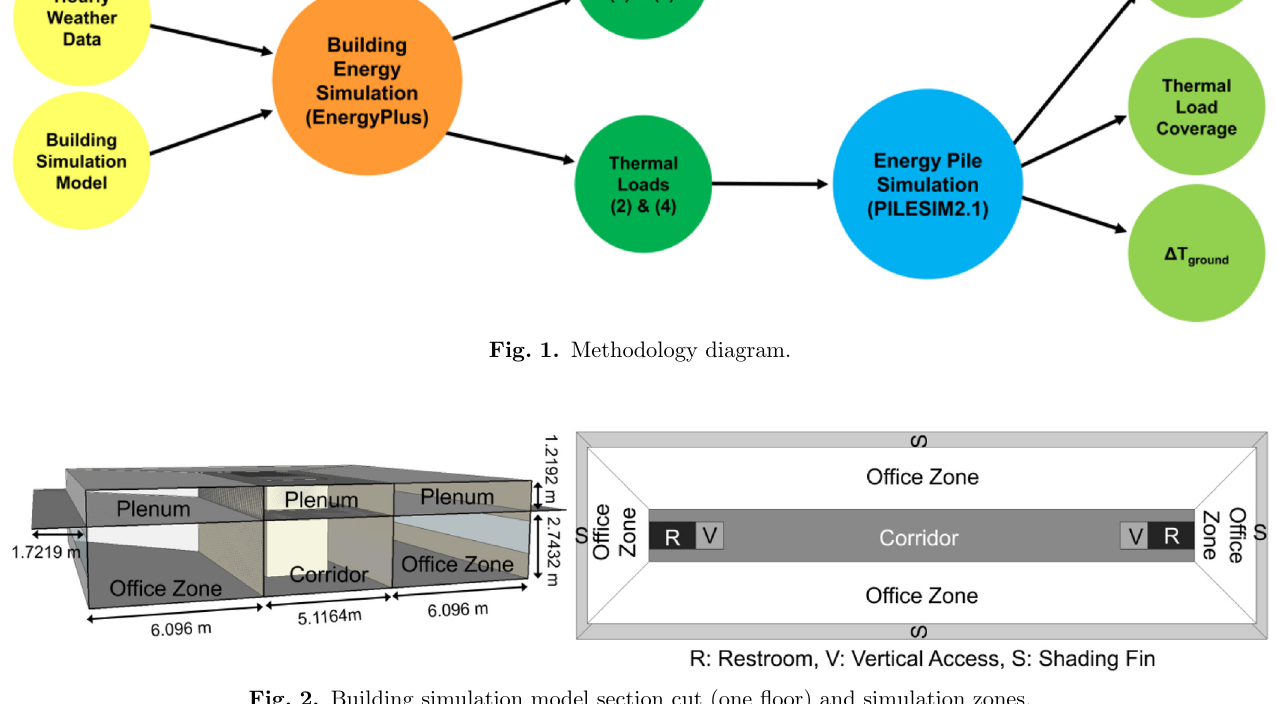
Fig. 2. Building simulation model section cut (one fl oor) and simulation